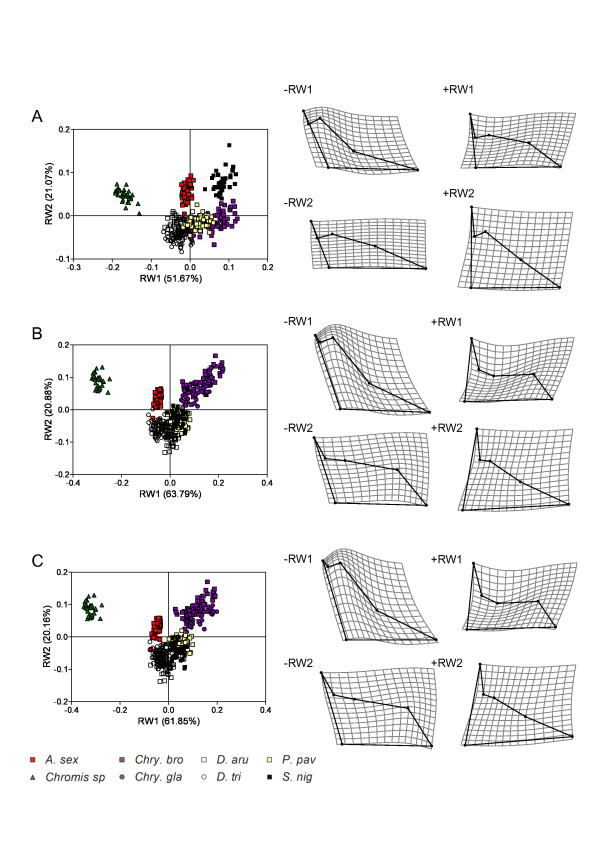
Ontogenetic dynamics of the patterns of premaxilla shape disparity. Relative warps analyses of the premaxilla shapes at the three ontogenetic stages. A, shapes at the settlement stage. B, shapes at an intermediate size of 60 mm SL. C, shapes at the maximum adult body size. TPS deformation grids indicate shape variation represented by RW1 and RW2 (minimal (-RW) and maximal (+RW) values).